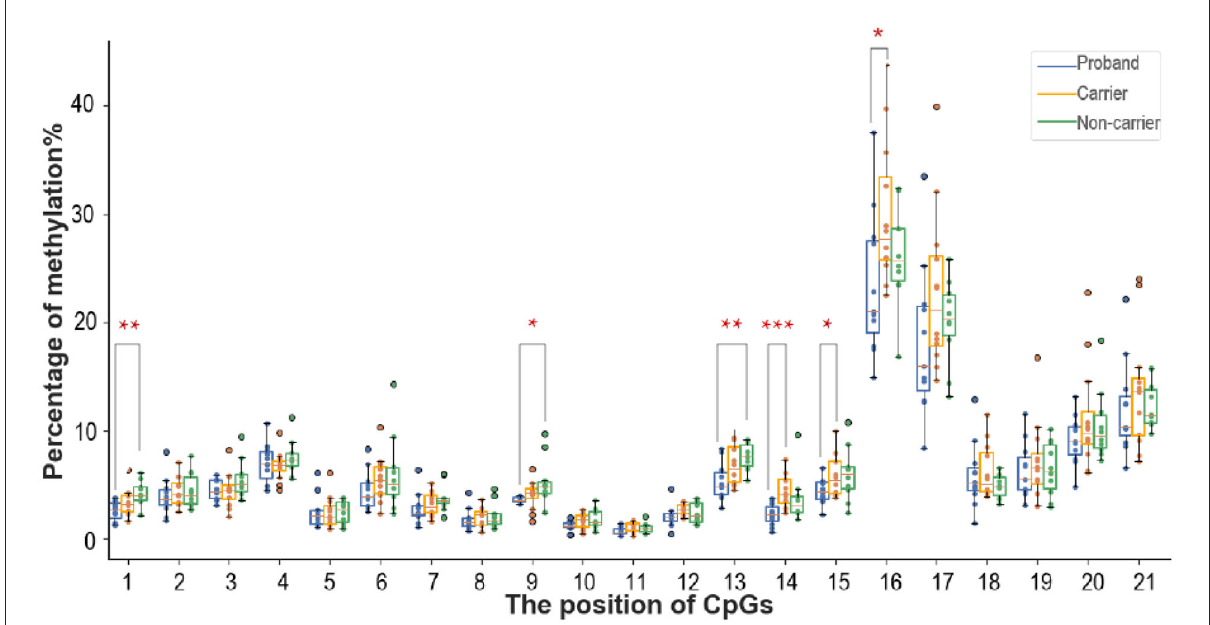
FIGURE3 The graph showed methylation levels of 21 tested CpG sites. The horizontal axis represented the position of CpG sites and the vertical axis represented percentage of methylation. Blue, orange and green points respectively indicated to 11 FEVR probands, 12 carriers and 11 non-carriers. Box plot data represented range (error bars), median (horizontal line), quartile values (box) and outliers (dots). Median methylation levels of probands, carriers and non-carriers were compared in pair using student’s t -test. DNA methylation levels of CpG1, CpG9 and CpG13 were significantly different between probands and non-carriers. DNA methylation levels of CpG14, CpG15 and CpG16 were significantly different between probands and carriers. *, p < 0.05; **, p < 0.01; ***, p < 0.001.